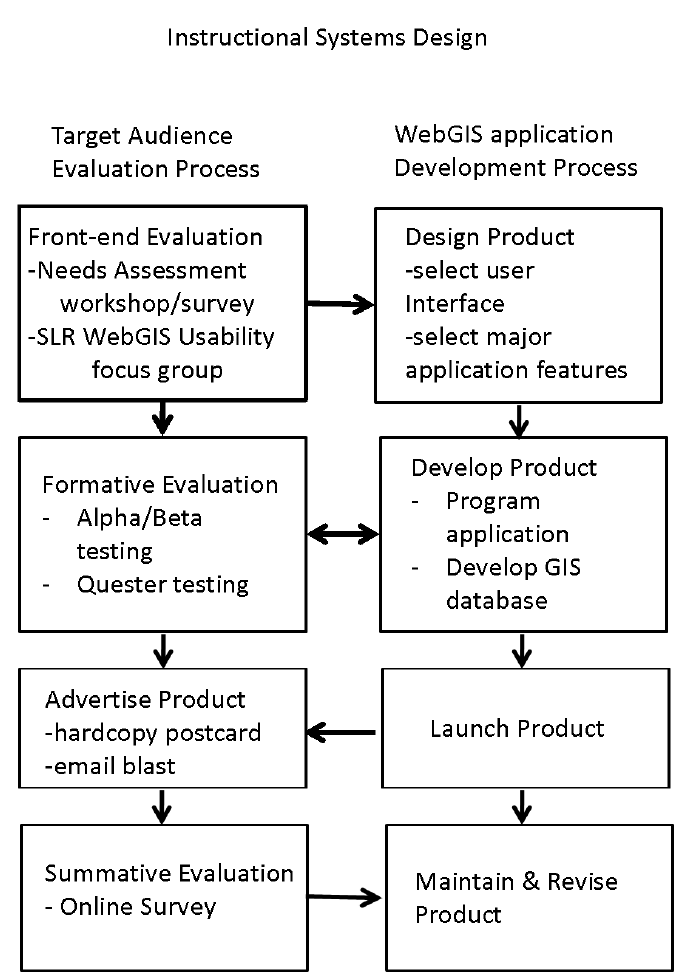
Figure 1. The instructional systems design process as adopted for our